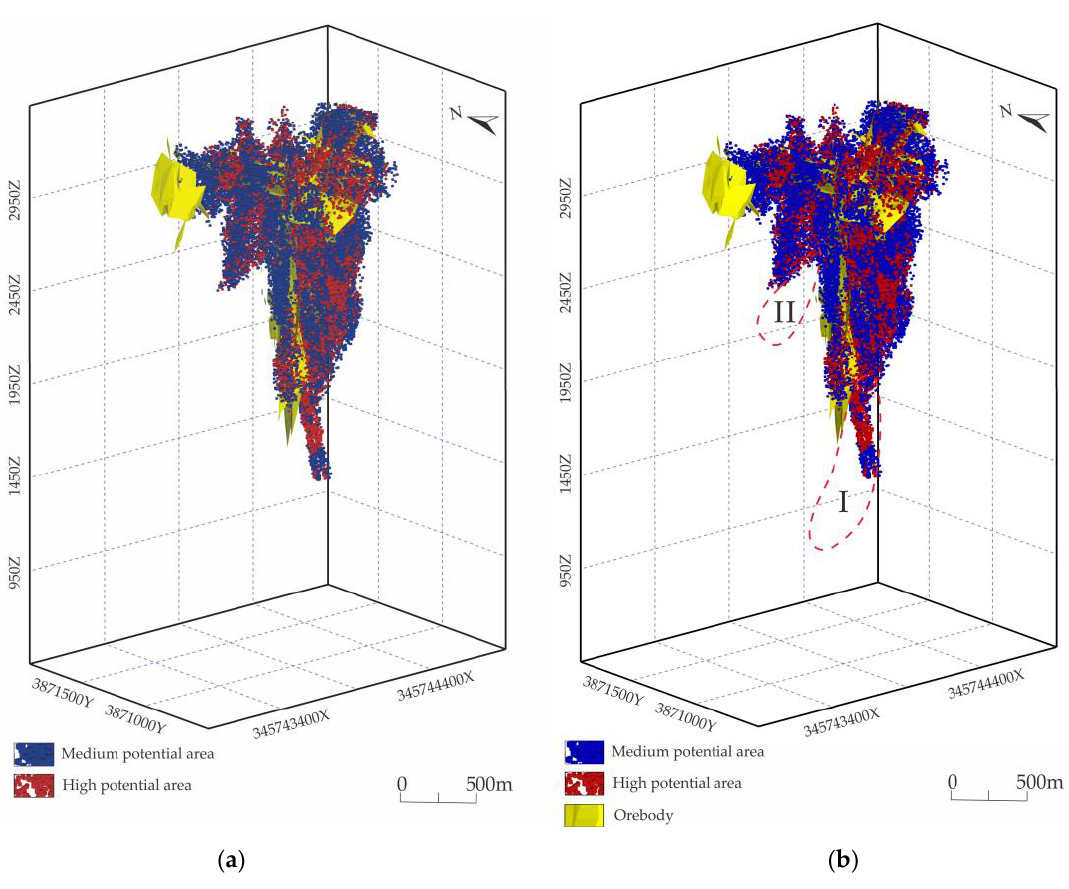
Figure 21. ( a ) The distribution of mineralization potential areas. ( b ) MaxEnt model-based exploration targets.